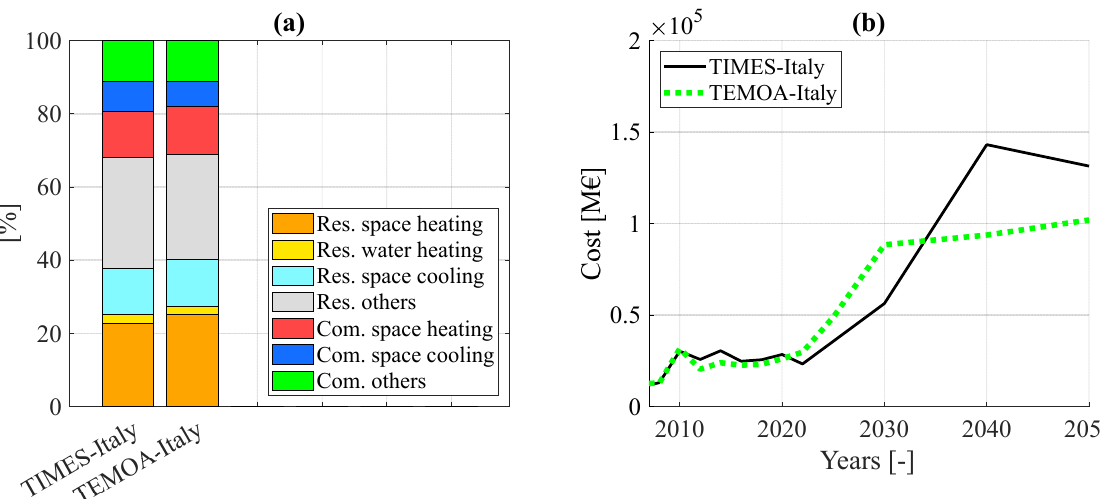
Figure 14. Comparison between the cumulative total cost of the buildings sector: ( a ) percentage sub-sectorial contributions; ( b ) evolution in time.